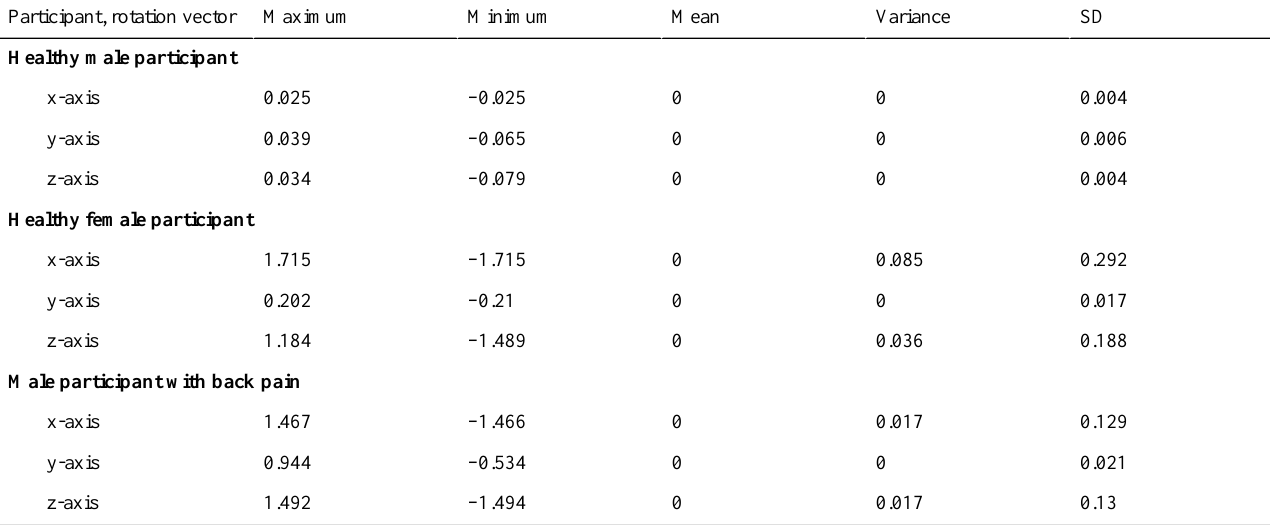
Table 1. Statistical information of the variations in the rotation vector